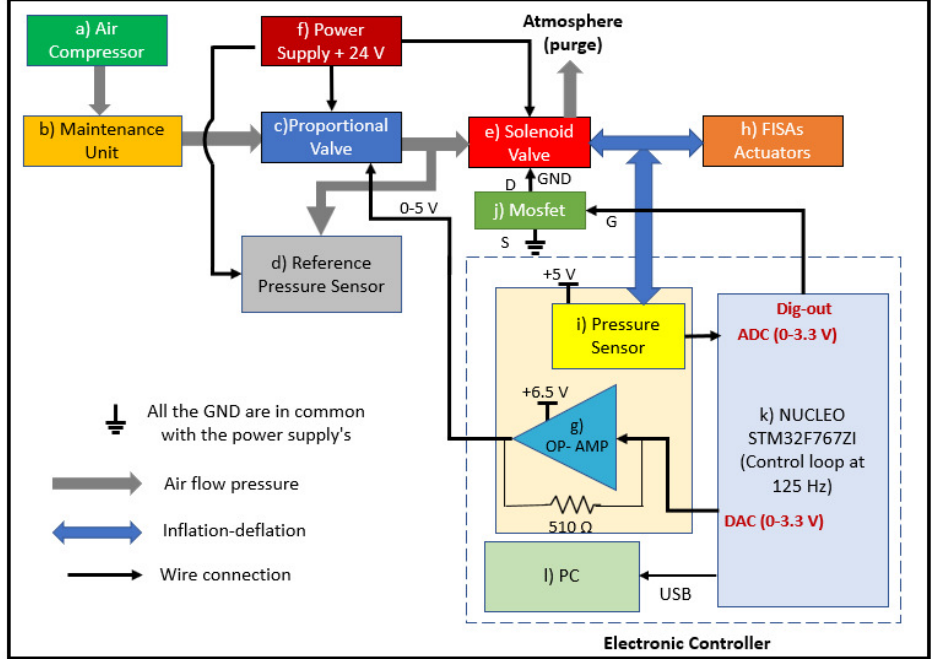
Figure 2. Block diagram of the FISAs system to control the inflation-deflation